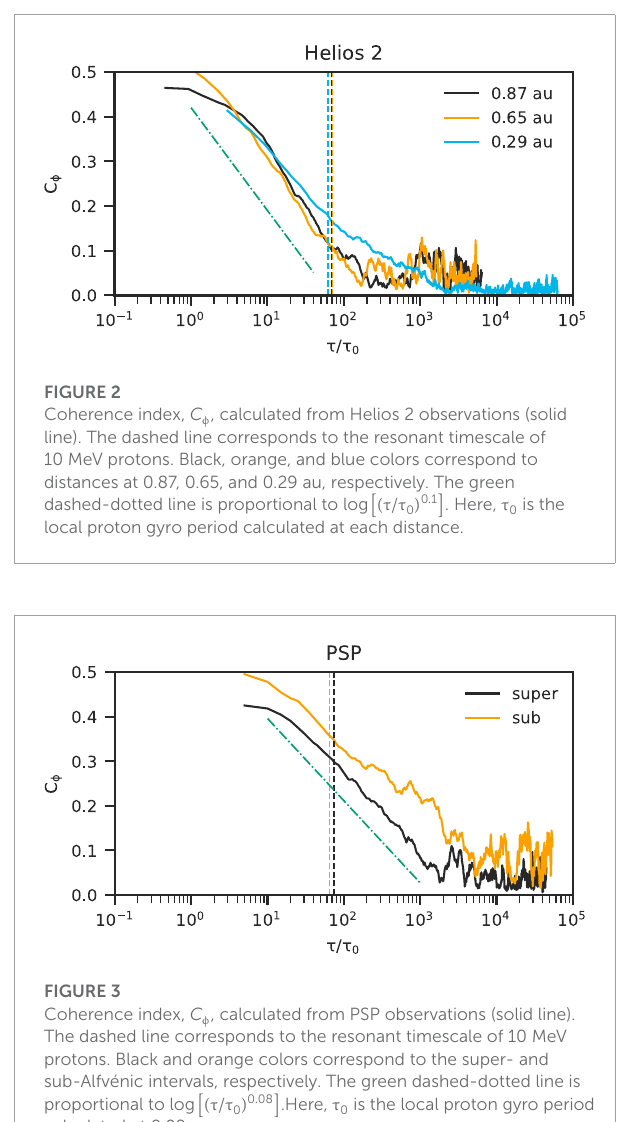
FIGURE 3 Coherence index, C ϕ , calculated from PSP observations (solid line). The dashed line corresponds to the resonant timescale of 10 MeV protons. Black and orange colors correspond to the super- and sub-Alfvénic intervals, respectively. The green dashed-dotted line is proportional to log [( τ / τ 0 ) 0 . 08 ] .Here, τ 0 is the local proton gyro period calculated at 0.09